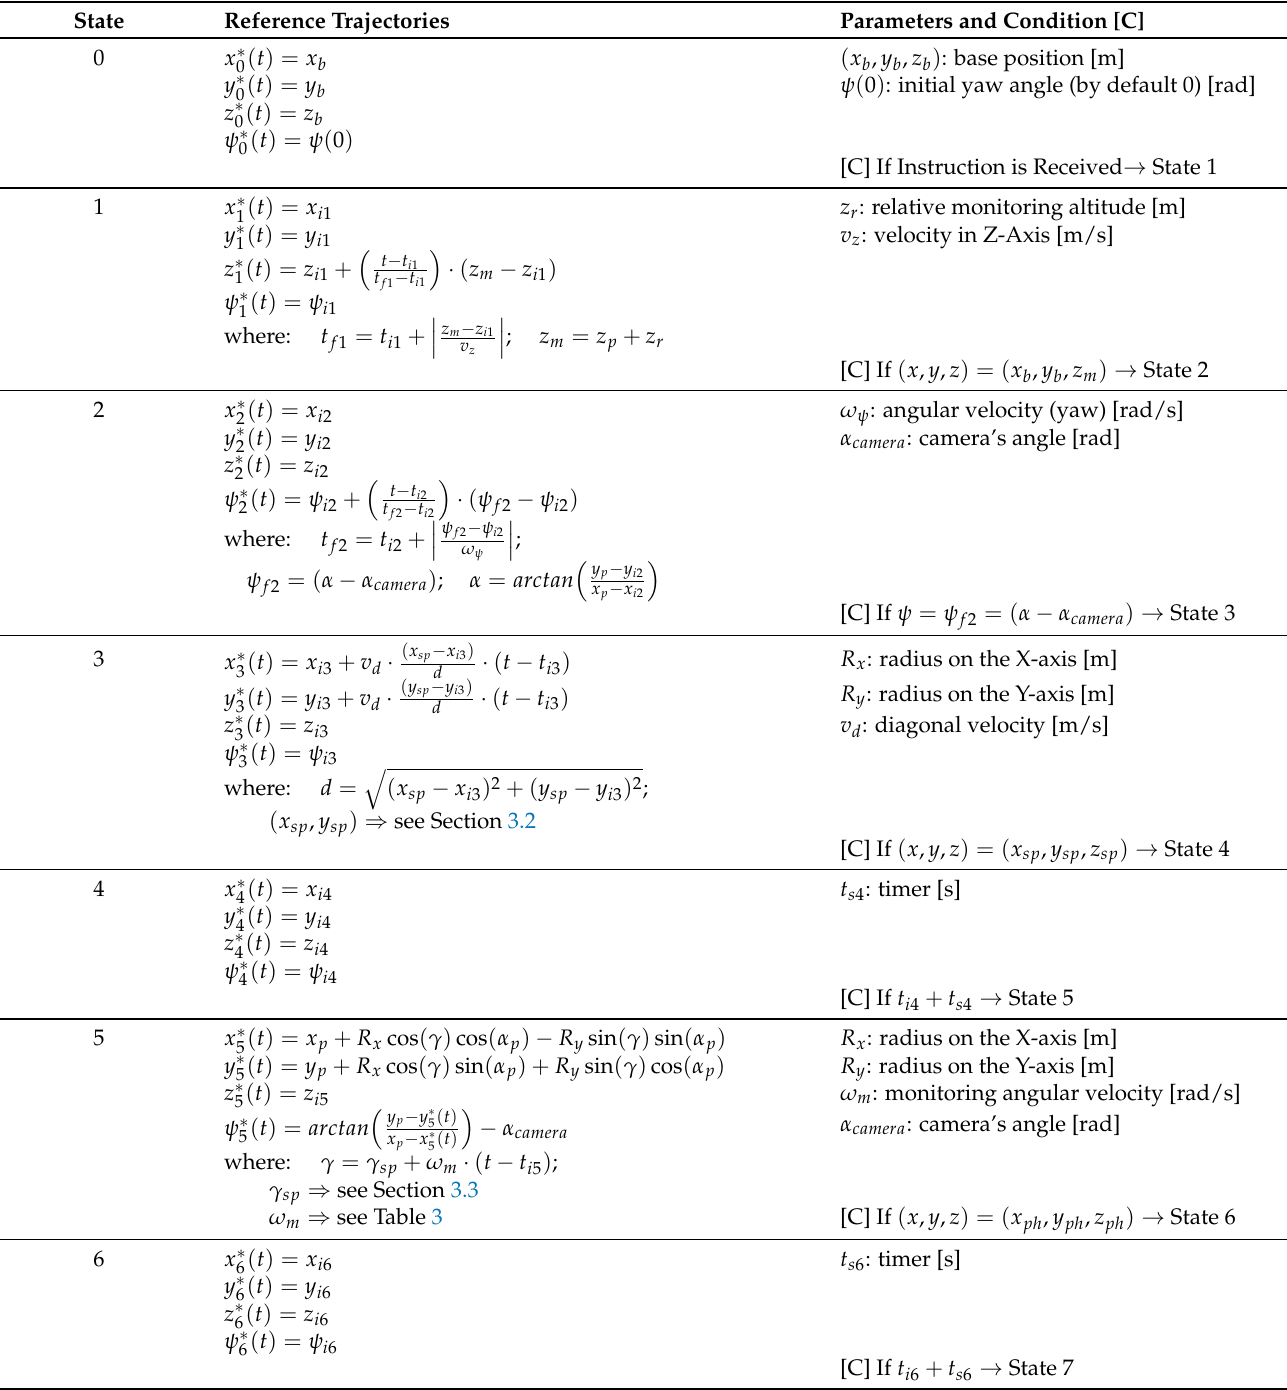
Table 1. Trajectory planner’s states for the monitoring process. (Part I—States from 0 to 6). Reference trajectories for the position ( x , y , z ) and yaw angle ( ψ ) of a quadrotor UAV monitoring a person whose position ( x p , y p , z p ) and orientation ( α p ) are